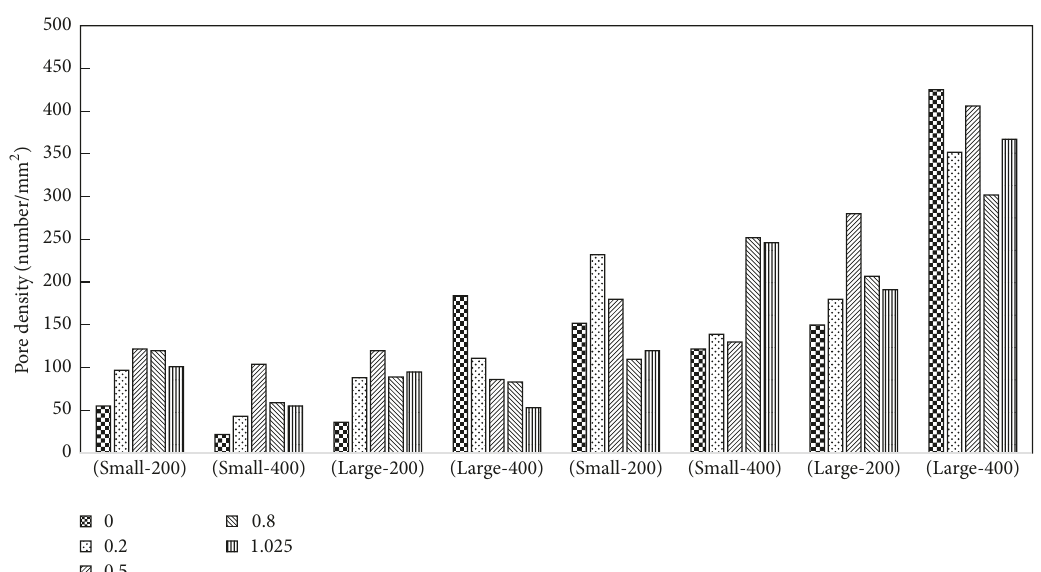
(b) Variation in pore density as a function of La content and casting/solidification condition of the A356 alloy samples (legend at the top center indicates the La level of the samples)